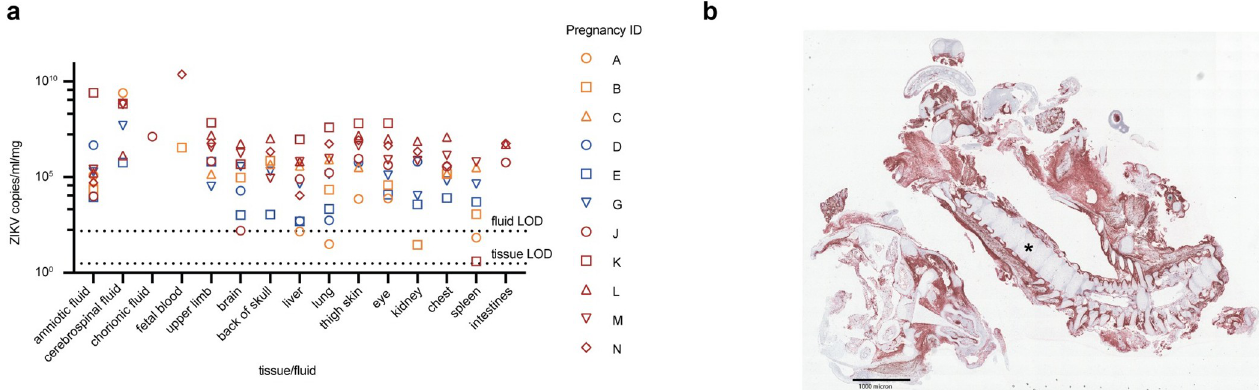
Fig 5. ZIKV was detected in tissues from the fetus/embryo in all cases of early pregnancy loss. Cohort I (SIV+/ZIKV+ +ART) animals are in orange, Cohort II (SIV-/ZIKV+ +ART) animals are in blue, and Cohort III (SIV-/ZIKV+) animals are in red. (a) ZIKV was detected in fetal/embryonic tissues from cases of early pregnancy loss by ZIKV-specific RT-qPCR. LOD denotes the limit of detection. (b) Representative image of ZIKV RNA (red staining) distribution in an embryo from a case of early pregnancy loss (Pregnancy N). Here, ZIKV RNA was detected in the periosteum and musculature of the head and body tissues. The asterisk denotes the vertebral column of the